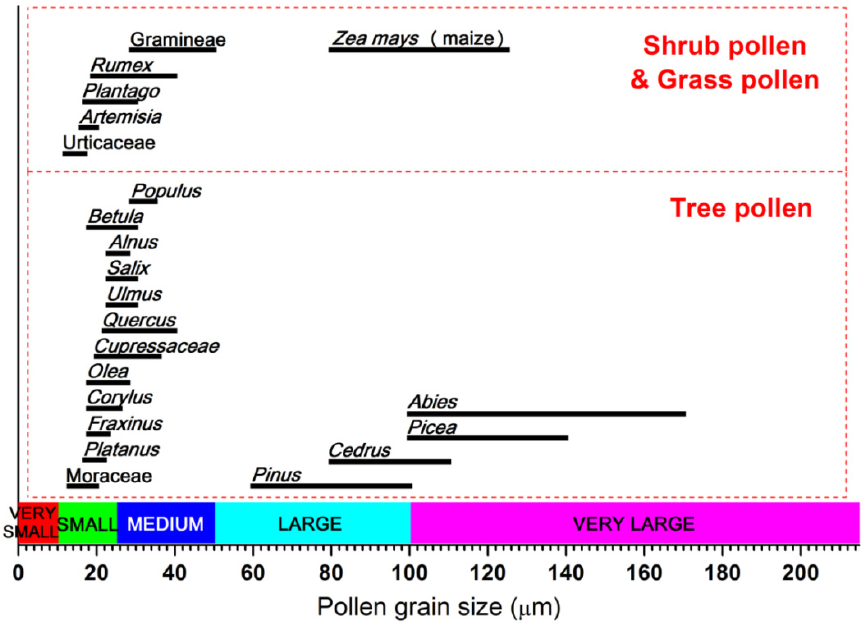
Figure 1. Single-grain size distribution of pollen of common Mediterranean plants (data gathered from [11,37,38]). The colored bottom bar and the black horizontal lines represent the grain size classes and the grain size spans of the vegetal families, genres or species, respectively.